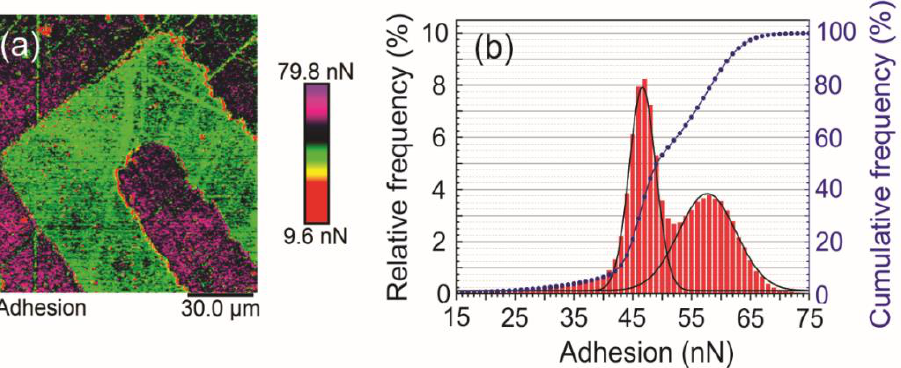
Figure 8. Adhesion analysis obtained by Atomic Force Microscopy. ( a ) AFM adhesion map over the sensor body. The map shows increased adhesion over the gold layer (purple) when compared with quartz substrate. ( b ) Adhesion values were plotted as a distribution and Gauss adjusted. Two dis-